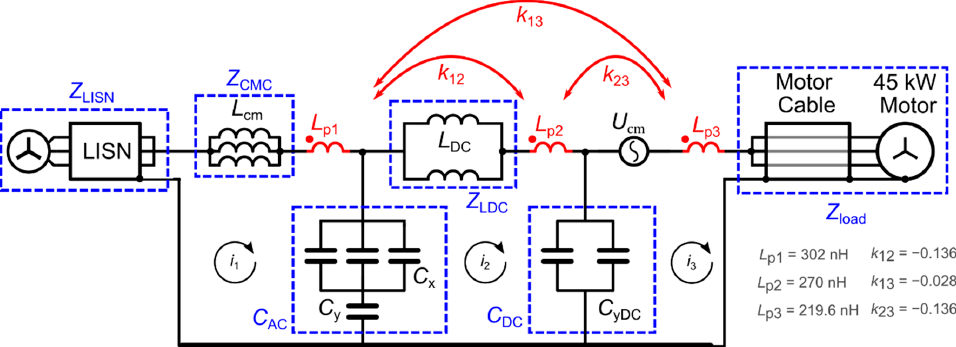
Figure 6. The equivalent CM circuit of the converter including magnetic parasitic couplings. The 3-phase circuit is shown in Figure 2.